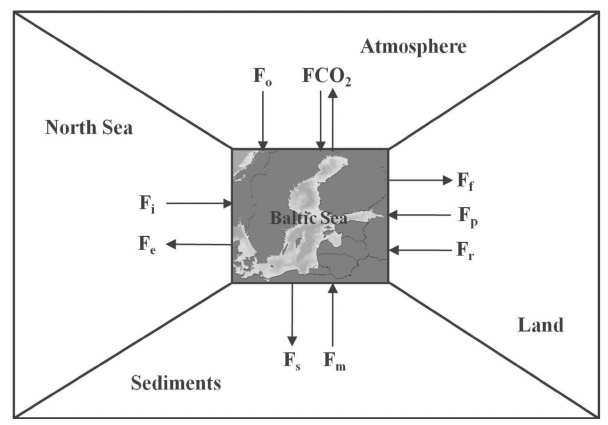
Fig. 2. Carbon sources and sinks in the Baltic Sea. Symbols: F e – export to the North Sea, F i – import from the North Sea, F o – atmospheric deposition, F CO 2 – net CO 2 exchange between sea- water and the atmosphere, F f – fisheries, F p – point sources, F r – river input, F s – accumulation in sediments, F m – return flux from sediments to the water